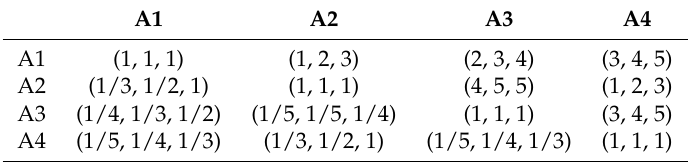
Table 3. A simple example of judgment matrix (triangular fuzzy